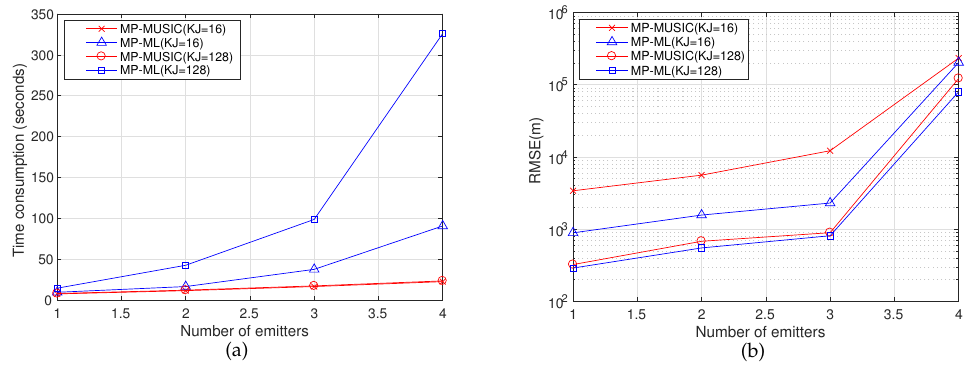
Figure 13. Time consumptions and RMSE of different numbers of emitters. ( a ) Time consumptions of MP-MUSIC and MP-ML ( b ) RMSE of MP-MUSIC and